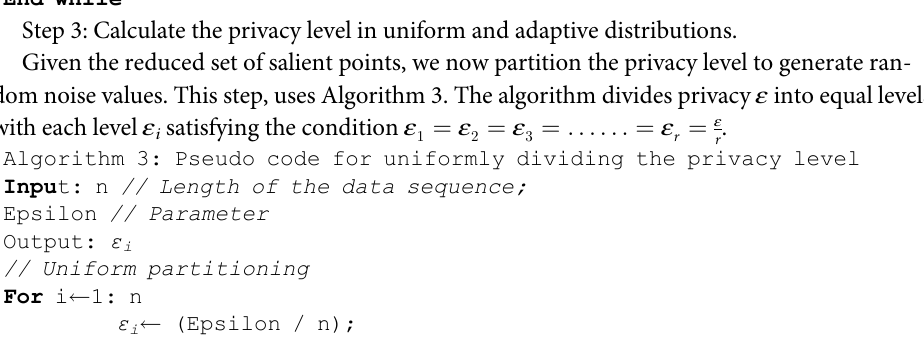
Algorithm 3: Pseudo code for uniformly dividing the privacy level